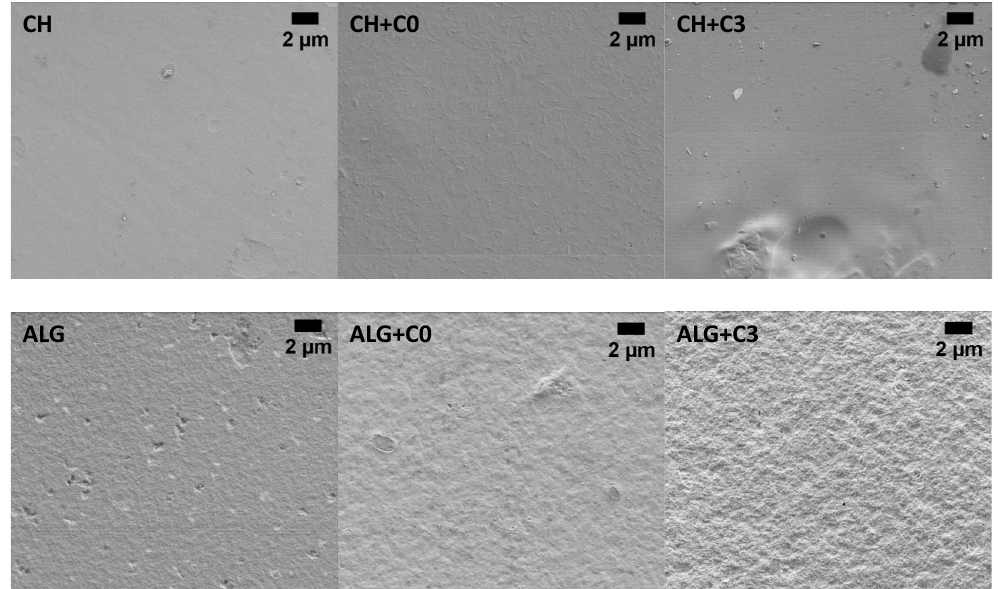
Figure 3. SEM micrographs of chitosan-based film (CH), chitosan films with pristine CNCs (CH+C0), chitosan films with acetylated CNCs (CH+C3) in the upper part and alginate-based film (ALG), alginate films with pristine CNCs (ALG+C0), alginate films with acetylated CNCs